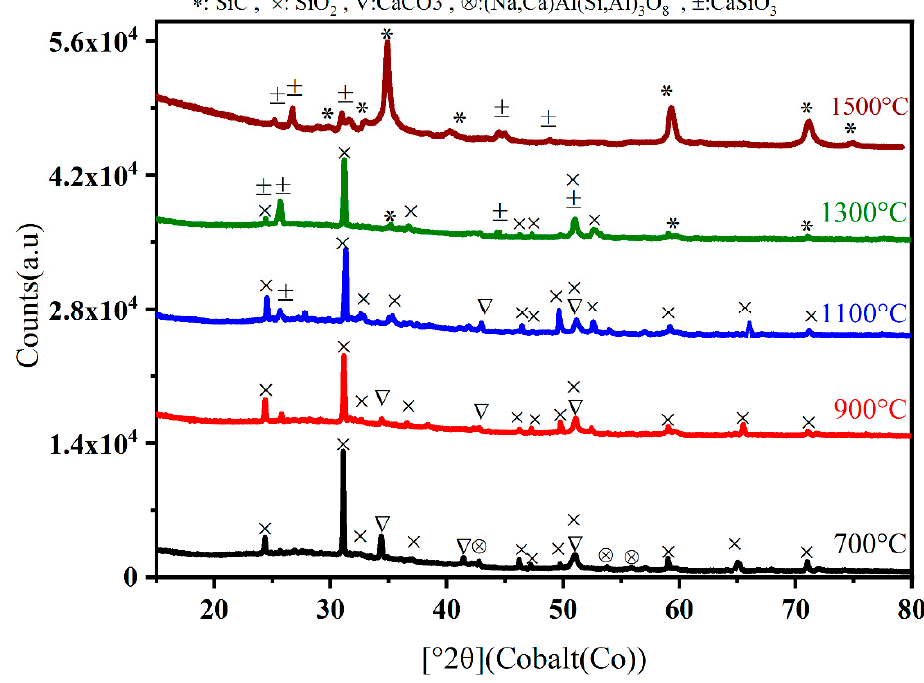
Figure 6. XRD spectrums of heat-treated mixed ASR plastics and glass at 700 °C to 1500 °C for 2 h . X-ray photoelectron spectroscopy (XPS) was used to study the chemical phenomenon occurring at surfaces of materials. XPS analysis of mixed ASR plastics and glass at 1500 ◦ C was conducted. The results of samples at 1500 ◦ C illustrates the reduction of SiO 2 with carbon to produce SiC. Additionally, Figure 7a and Table 3 depicts the highest peaks belonging to O1s with binding energy 532 eV with concentrations of the formed atom was 28.86%, which could result from contamination caused by exposure to oxygen in the with concentrations of the formed atom 22%, 29.96%, 1.84%, respectively. As shown in Table 3 and Figure 7b, Si2p has two peaks around 101 eV, 102.5 eV allocated to SiC and SiO 2 [69–71]. High-resolution XPS spectrum of C1s indicates that the highest peak C1s C (283 eV) associated with high-coordination C–Si, and C1s A (284.8 eV) related to C–C as reported by McKenna, J. et al. [72]. As stated by Lee, K. H. et al. [73] Si2p with